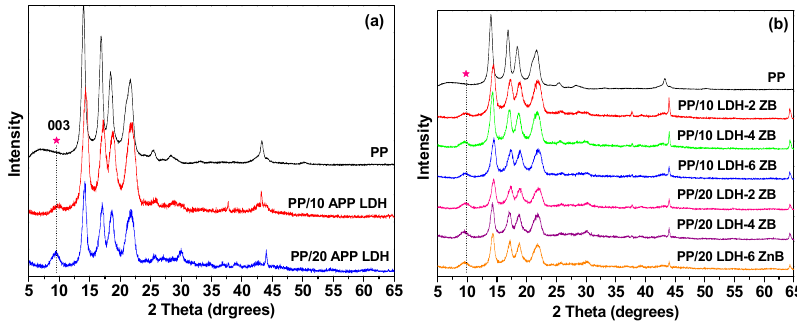
Figure 4. XRD patterns of PP, ( a ) PP/APP-LDH, and ( b ) PP/APP-LDH/ZB nanocomposites.